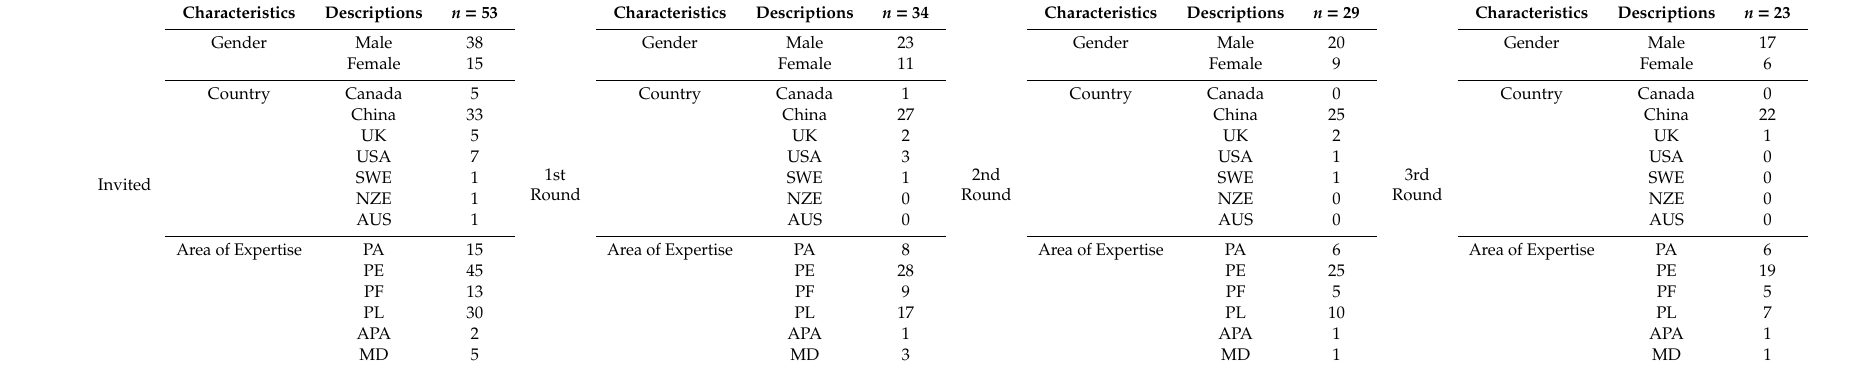
Table 1. Characteristics of experts participating in each round of the Delphi